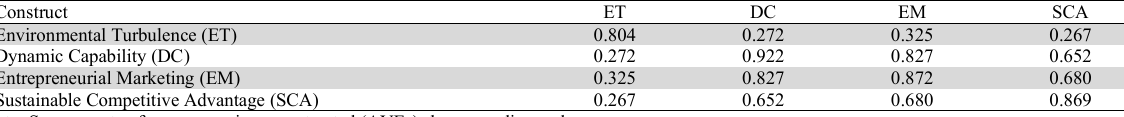
Correlations among l. vs. with sq. rts. of AVEs Construct